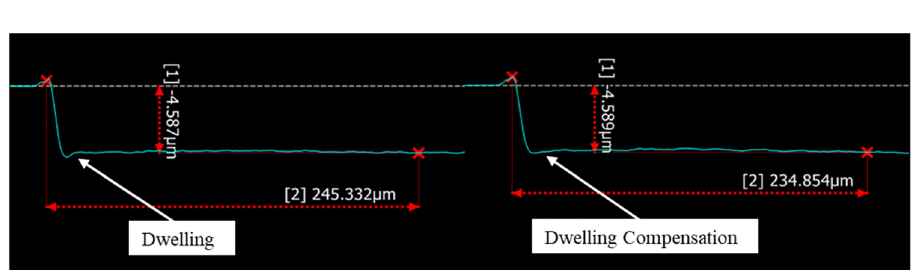
Figure 11. An example of dwelling caused by scanner mirror acceleration (left). Dwelling compensation utilizing a developed intelligent scanning system